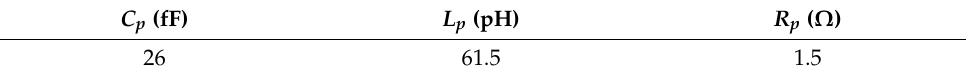
Table 4. Extracted parameter values of the UTC-PD de-embedding test structures.